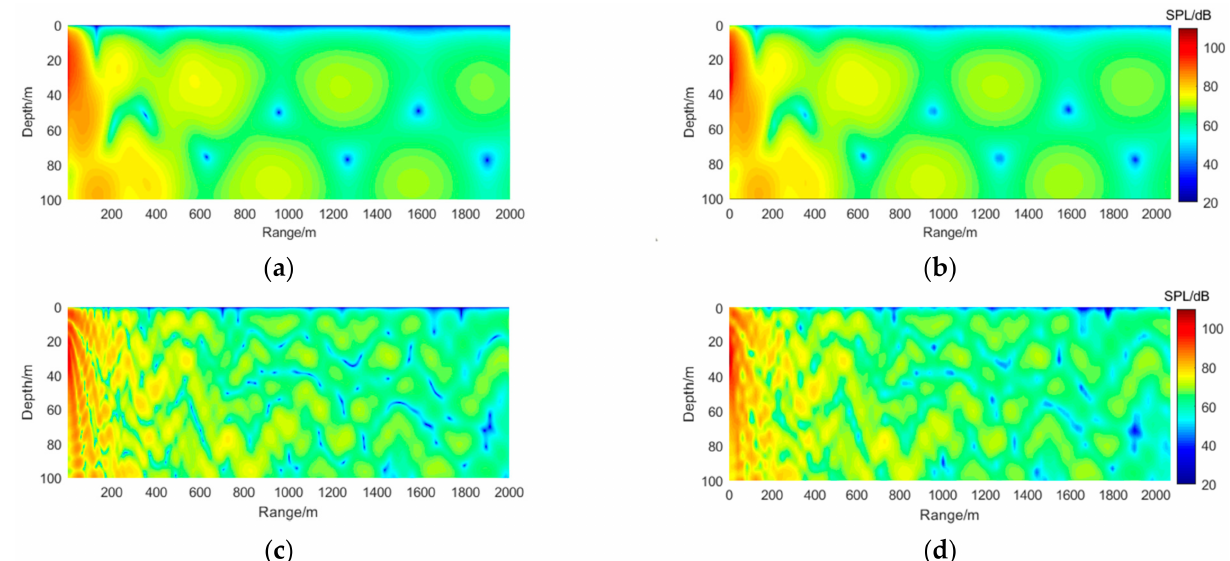
Figure 6. The SPL comparison of the GF with different frequencies: ( a ) f = 25 Hz, WI; ( b ) f = 25 Hz, the presented method; ( c ) f = 100 Hz, WI; ( d ) f = 100 Hz, the presented